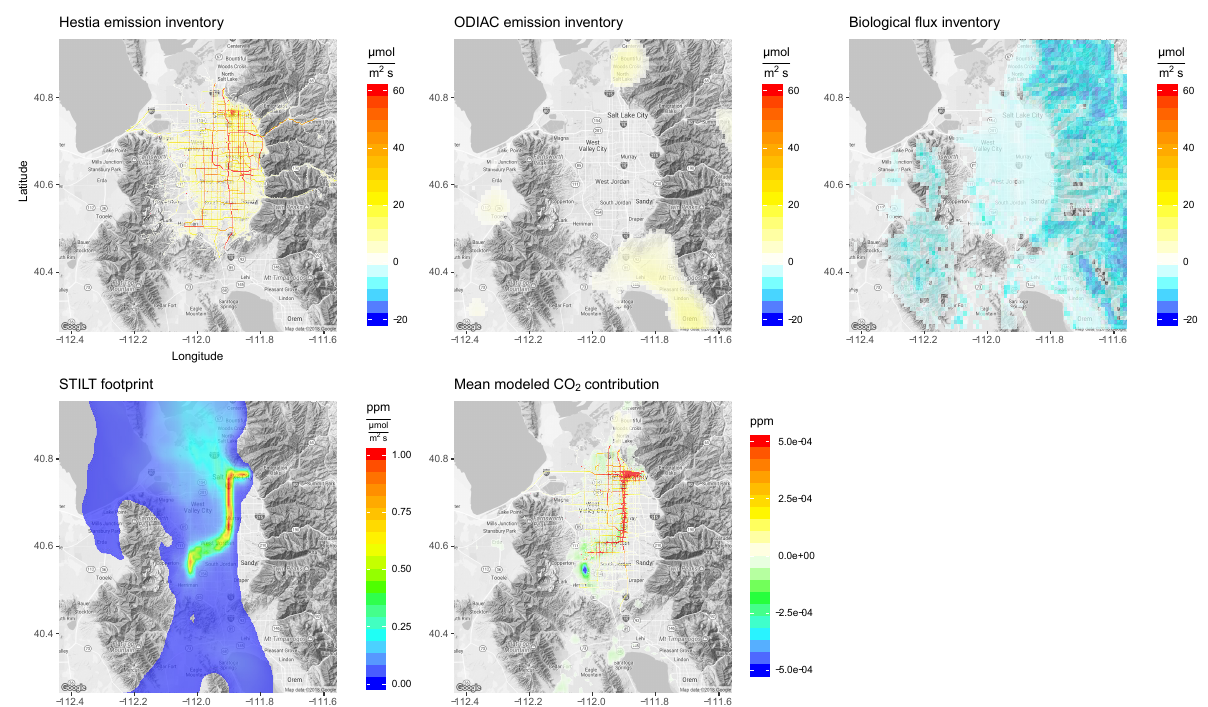
Figure 6. July 2015 afternoon Salt Lake Valley (SLV) Hestia-derived and non-SLV ODIAC-derived anthropogenic CO 2 emissions, biological fluxes, and average STILT footprint. The anthropogenic and biological flux inventories convolved with the footprints give the contribution of near-field fluxes to measured mole fractions in parts per million. The light-rail train is highly sensitive to HNF emissions sources and is strongly influenced by large roadways and agriculture adjacent to the